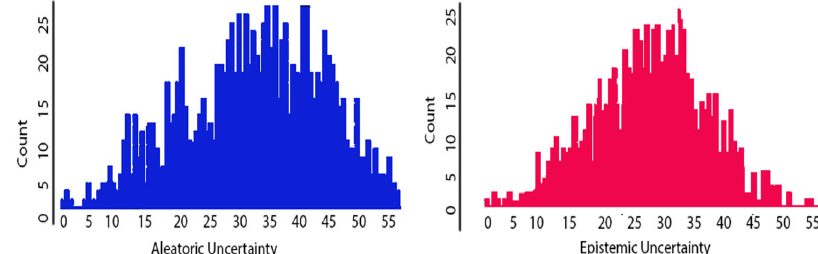
Fig. 5 Distributions of internal assessment percentage of the students concerning results.